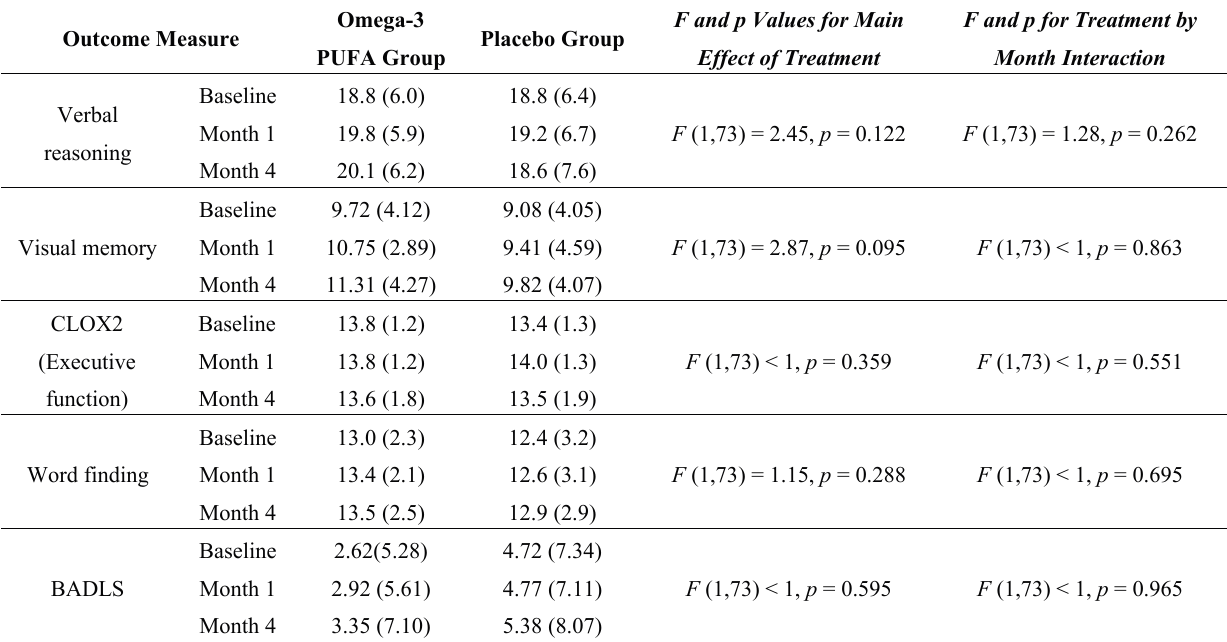
Table 3. Secondary outcome measure performance scores over the study duration. BADLS, Bristol’s Activities of Daily Living Scale; CLOX2, clock drawing task 2; PUFA, polyunsaturated fatty